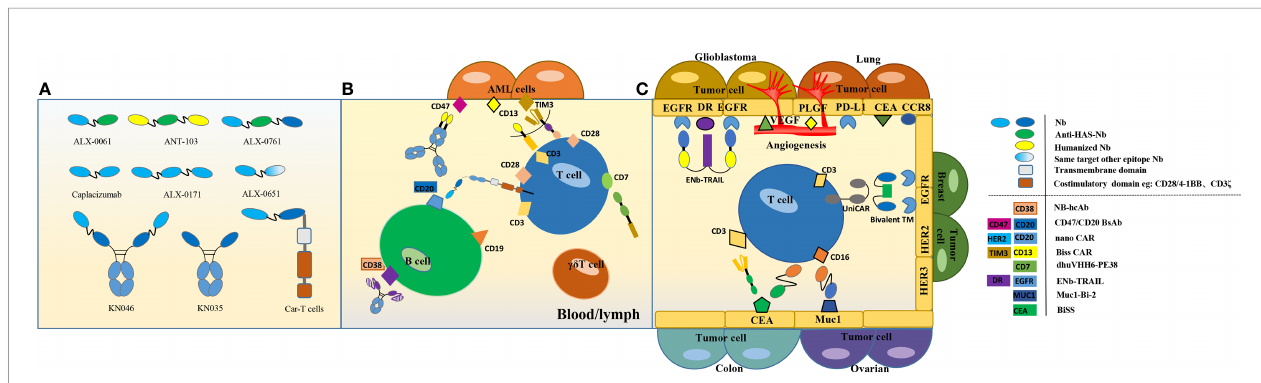
FIGURE 1 | Formats and strategies for multivalent/multispeci fi c nanobodies. (A) Formats of multivalent mono/bispeci fi c nanobodies that entered in clinical trials. (B) Multivalent mono/bispeci fi c nanobodies applications for blood/lymph cancer therapy. Several CAR-T cell therapies are based on nanobodies and have shown promising effects, for instance in B cell lymphoma. The most commonly targeted receptors on B- and T-cells are CD19, CD20 and CD3, respectively (52). (C) Multivalent/bispeci fi c nanobody applications for solid cancer therapy target surface biomarkers of epithelial cancer cells. Multi-functional nanobody structures target multiple epitopes or antigen combinations, resulting in synergistic therapeutic effects for tumors that do not respond to single-target antagonists